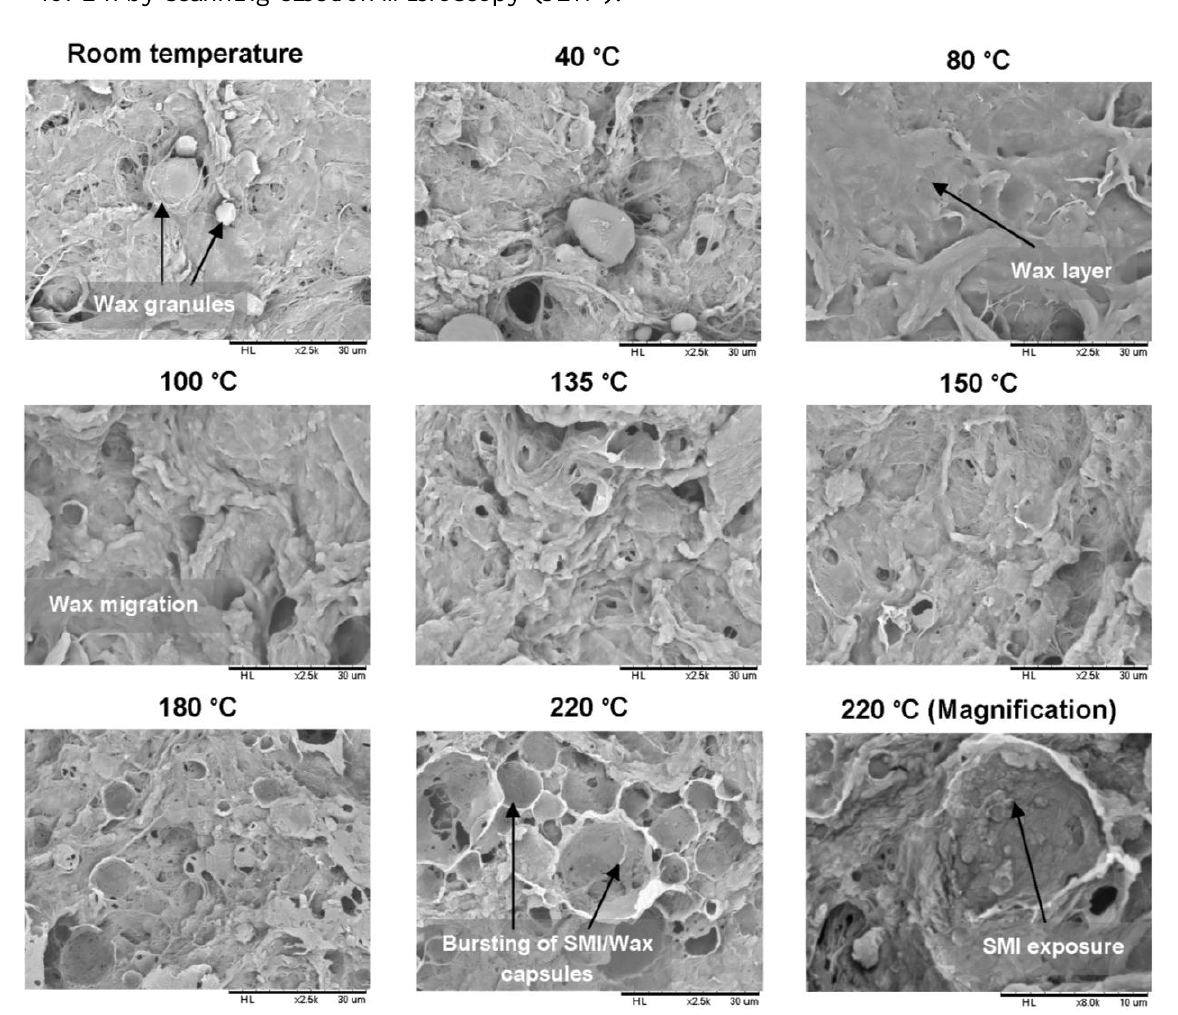
Figure 5. Morphology of non-cured and cured modified MFC films at different temperatures for 2 h by scanning electron microscopy